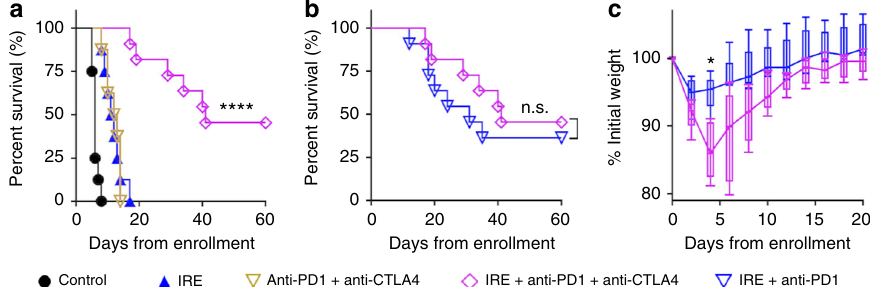
Fig. 2 Survival of KRAS* model treated with IRE, anti-CTLA4, and/or anti-PD1. a Kaplan – Meier survival curves of mice in sham control (black solid circle, n = 8), anti-CTLA4 + anti-PD1 (brown triangle, n = 8), IRE only (blue solid triangle, n = 8), and IRE + anti-CTLA4 + anti-PD1 groups (magenta diamond, n = 11). **** p < 0.0001, log-rank test. b Survival of IRE + anti-CTLA4 + anti-PD1 ( n = 11) and IRE + anti-PD1 (blue triangle, n = 11) groups, n.s. not signi fi cant, log-rank test. c Relative change in mouse body weight after treatment with IRE + anti-CTLA4 + anti-PD1 or IRE + anti-PD1 ( n = 5 each group). Data presented as interquartile range (IQR) with a median center line and min to max error bars, * p < 0.05, double-sided Student ’ s t -test. Source data are provided as a Source Data fi